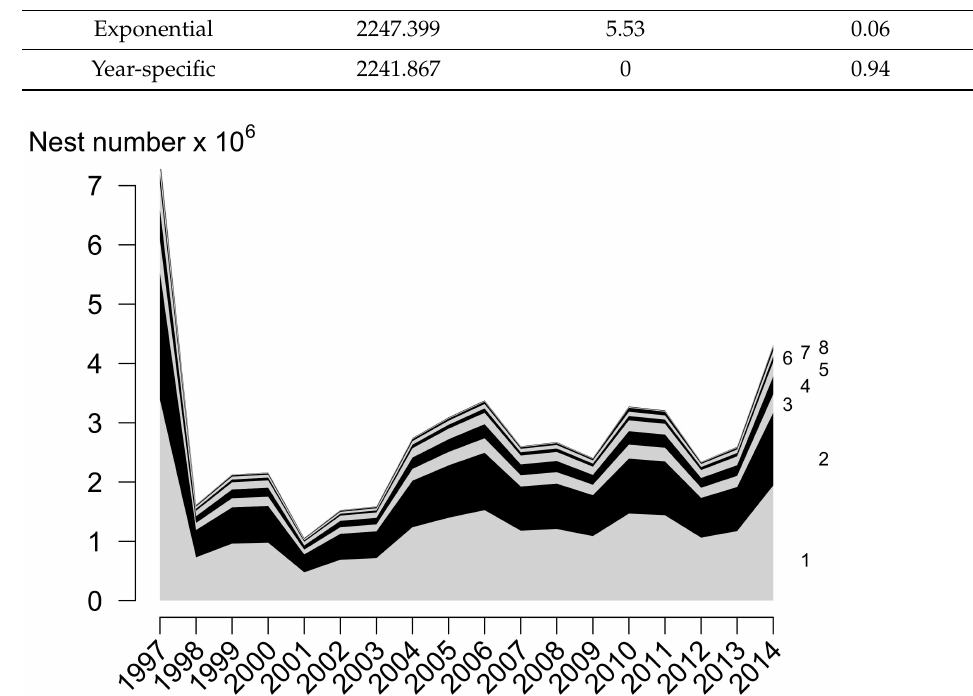
Figure 2. Temporal and spatial distribution of the number of olive ridley nests in Central America. Only eight major beaches are named here from among the 90 beaches used in the present study because the number of nests per year for other ones is too small to be visualized in the figure. Beaches: 1: Santuario